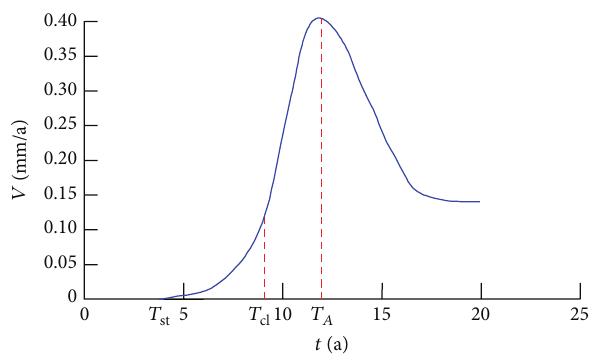
Figure 1: Corrosion rate curve for offshore steel pipe piles for wind